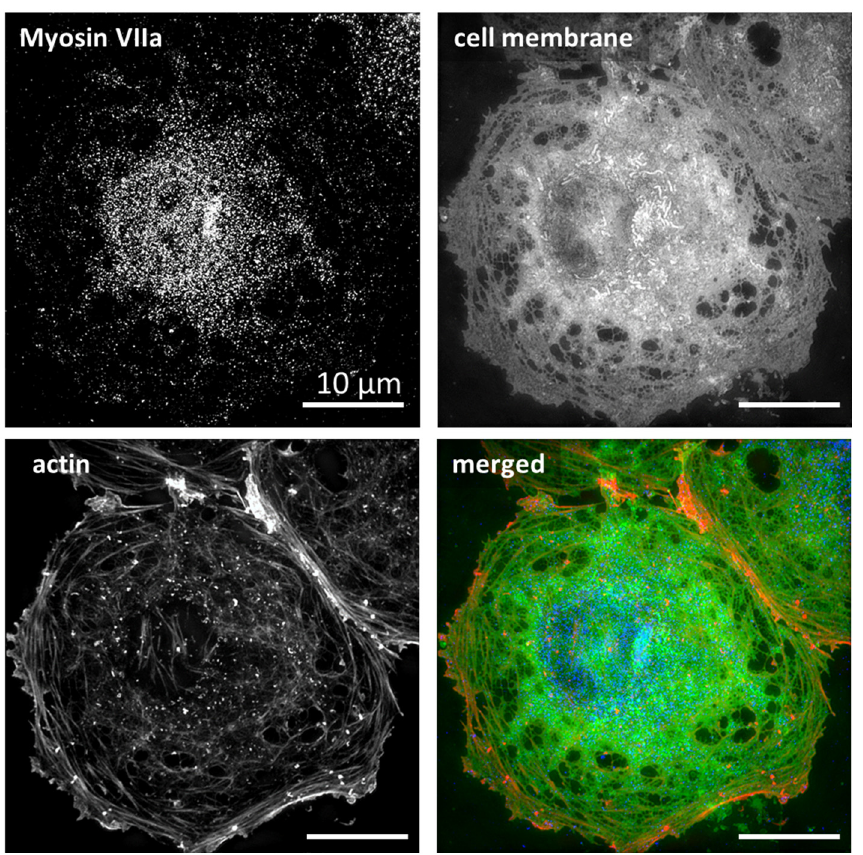
Figure 6. SIM projection images of a representative LSEC (control, untreated cells). Myosin VIIa/MYO7A rabbit antibody (1:100), secondary donkey anti-rabbit, Alexa 488 (1:100), cell membrane-CellMask Orange, actin-phalloidin-Atto647N. Image size: 40.96 µm × 40.96 µm.